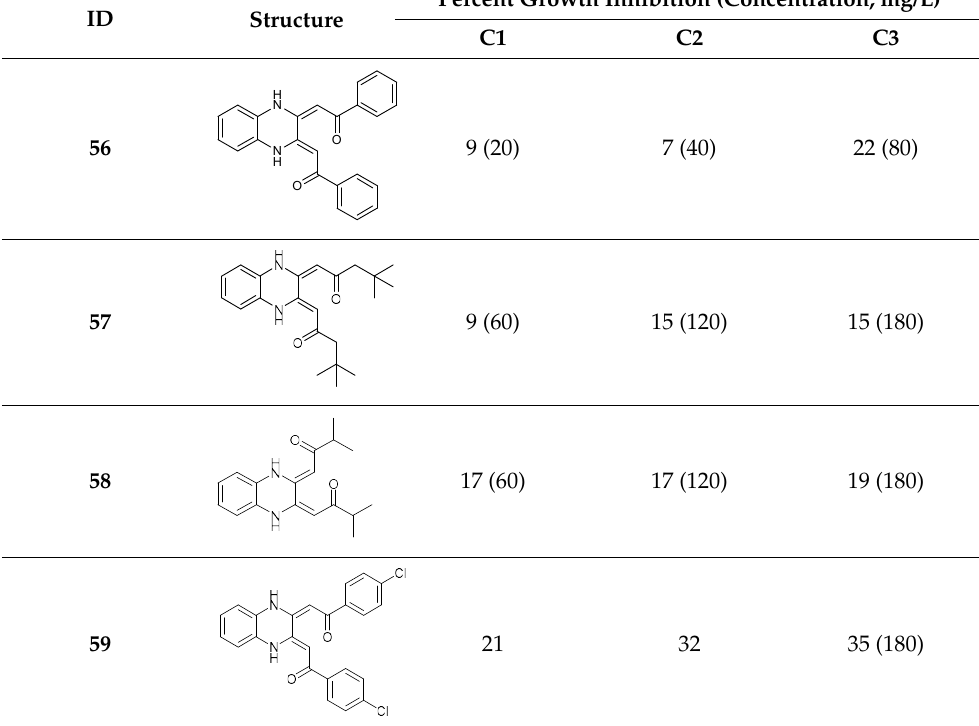
Table 7. Percent growth inhibition at different concentrations for quinoxaline compounds tested against F.o.a.